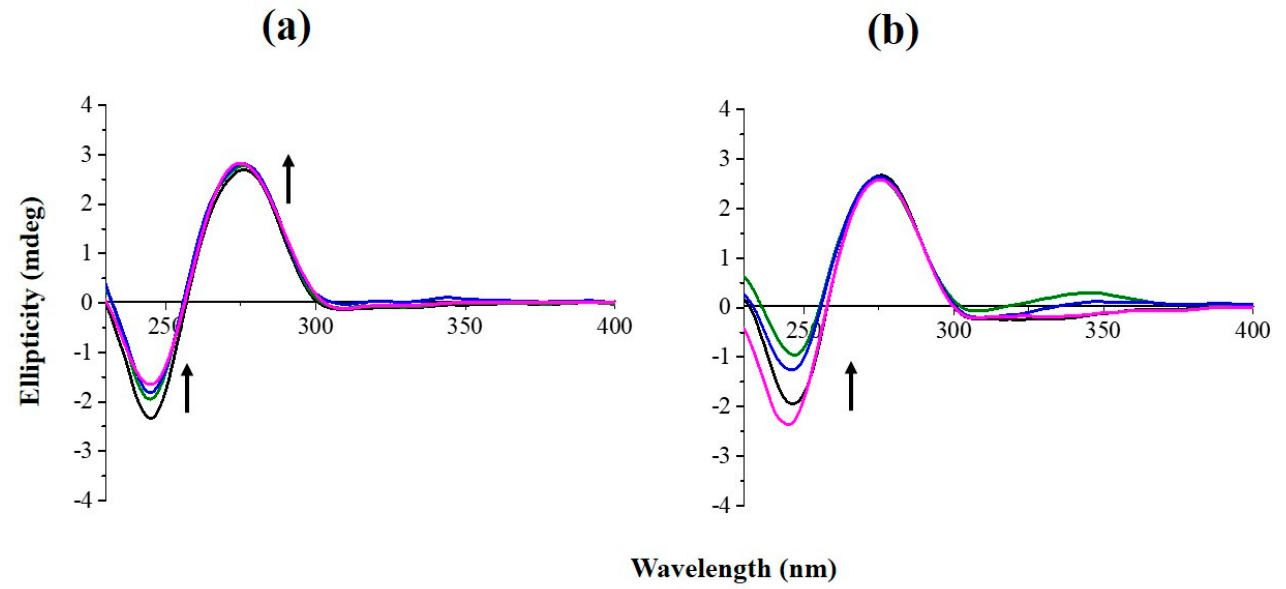
Figure 5. Circular dichroism spectra of DNA (5 × 10 − 5 M) with increasing amounts of Cu-1 ( a ) and L1 ( b ) (0–2.5 × 10 − 5 M). Indicative ratios R = [compound]/[DNA] are shown: R = 0 (black line), R = 0.05 (green line), R = 0.2 (blue line), R = 0.5 (magenta